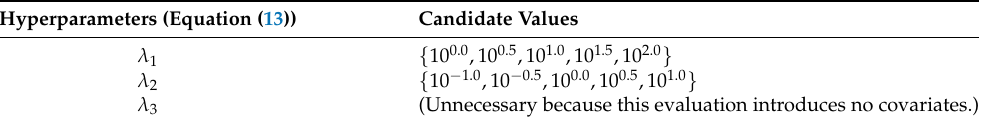
Table 1. Candidate values for tuning the hyperparameters.